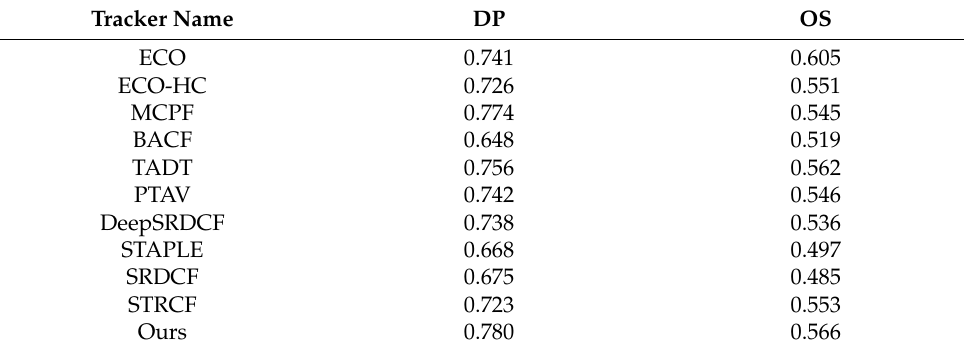
Table 2. The overall tracking results on the TC-128 datasets.